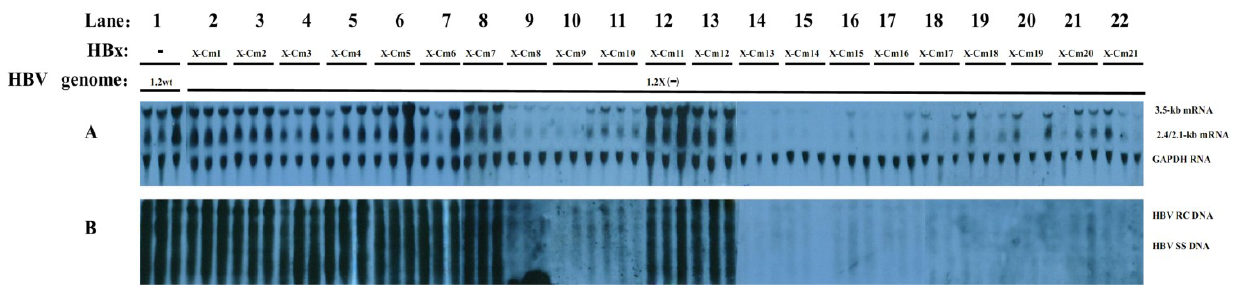
Figure 3. Mapping of the HBx sequences required for the stimulatory effect on HBV transcription and replication in vivo . Male BALB/c mice were introduced by hydrodynamic injection with the wild-type HBV construct payw1.2 (1.2wt, lane 1) or the HBx-deficient HBV construct payw*7 [1.2X(–), lanes 2–22] plus a series of clustered mutated HBx expression plasmid vectors (X-Cm1 to X-Cm21, lanes 2-22, respectively). ( A )